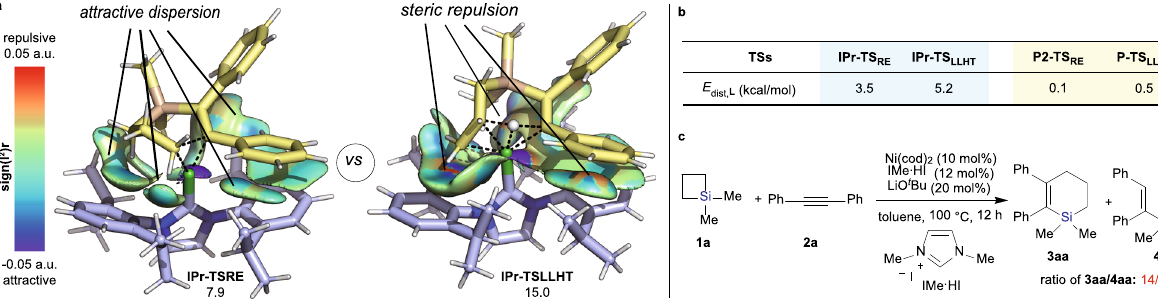
Fig. 5 Ligand steric effects on divergent cycloaddition. a Visual analysis of non-covalent interactions 47 . b Ligand distortion energies. c The reaction of